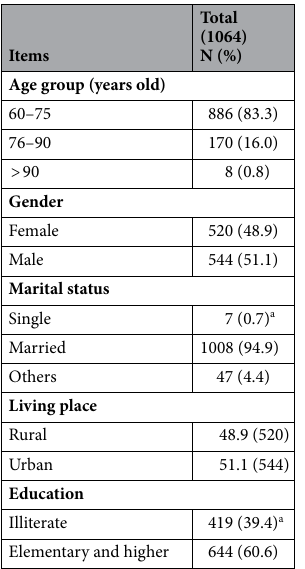
Table 2. Demographic characteristics of Iranian older adults. a There were missing values. We calculated the prevalence on valid